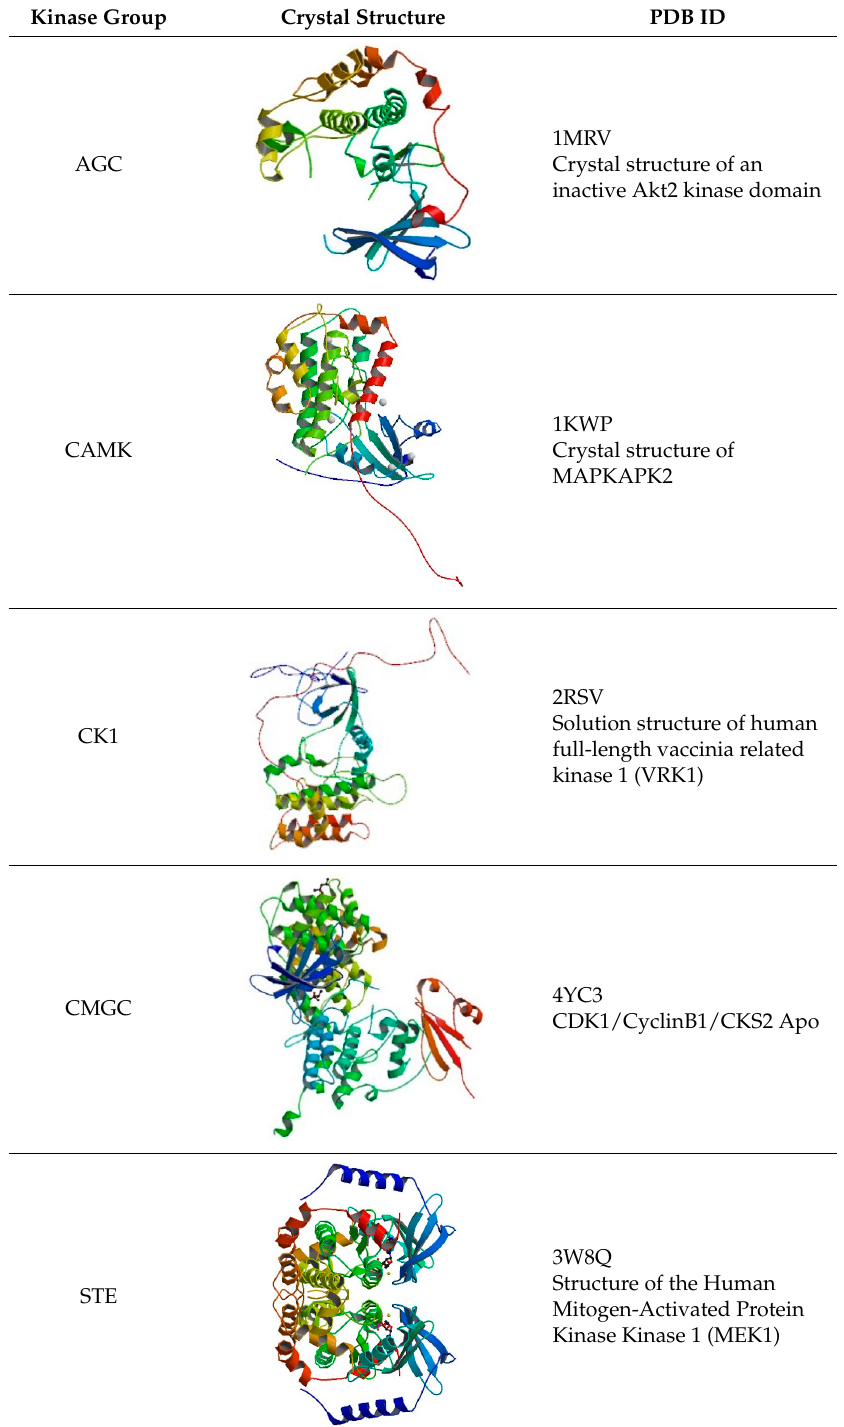
Table 1. Proposed structures for the main protein kinase family groups.